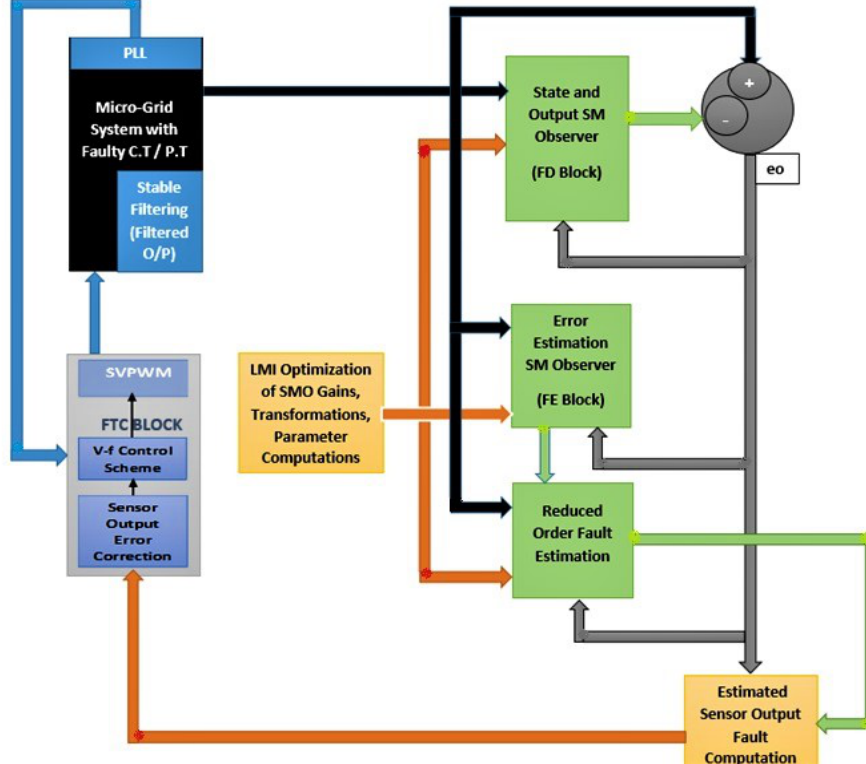
Figure 1. Complete block diagram of the used